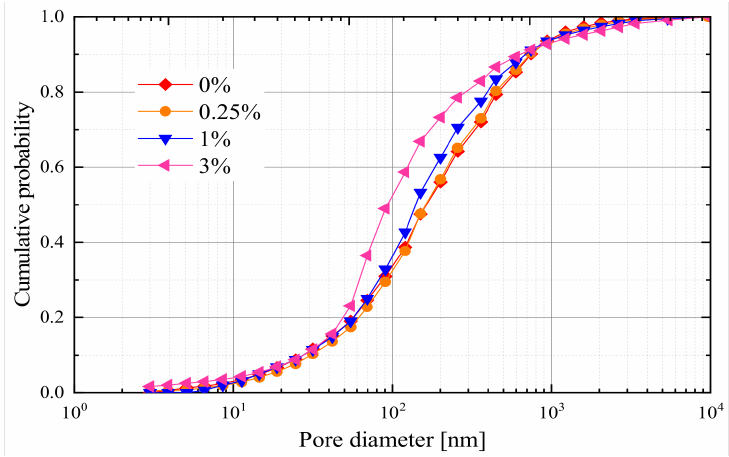
Figure 4. The accumulated pore diameter distribution curves of NS-modified silty clay